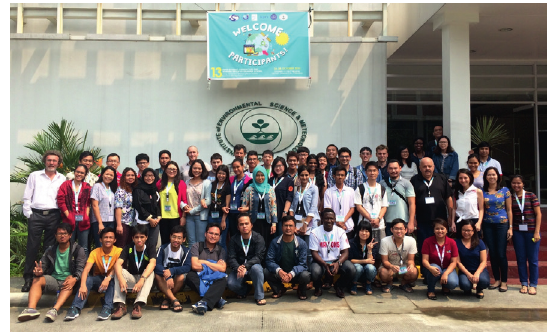
Figure 4. Group photo at the 2015 summer school in the